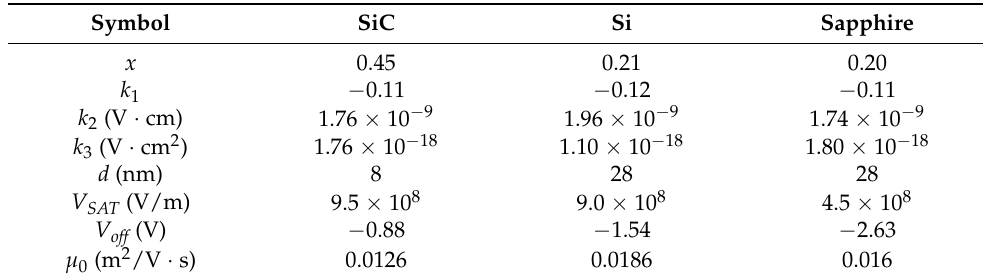
Table 3. Parameters used in